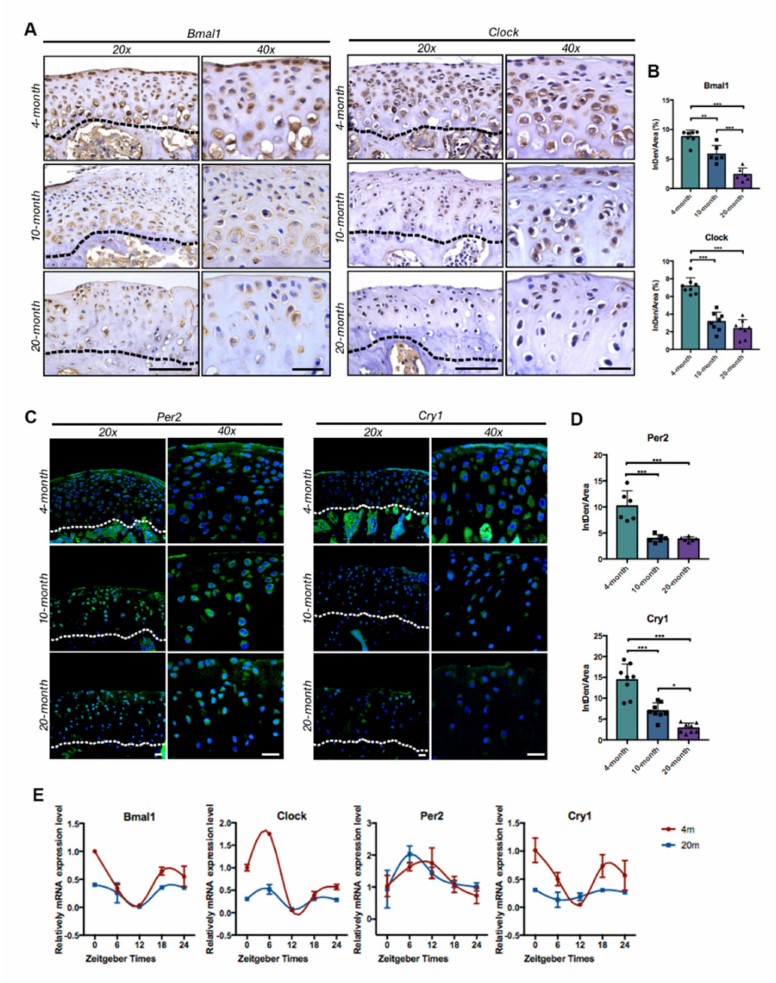
Figure 3. Decreased expression of core circadian clock genes and blunted molecular rhythms of aged TMJ cartilage. ( A ) Representative images of immunostaining for BMAL1 and CLOCK in TMJ condyles in different age groups. Scale bar: 75 µ m for 20 × and 25 µ m for 40 × . ( B ) Quantification of percentage of positive staining in data A ( n = 6–8) * p < 0.05, ** p < 0.01, *** p < 0.001. ( C ) Representative images of immunostaining (fluorescent) for Per2 and Cry1 in TMJ condyles in different age groups. Scale bar: 20 µ m. ( D ) Quantification of percentage of positive staining in data C ( n = 6–8) * p < 0.05, ** p < 0.01, *** p < 0.001. ( E ) qRT-PCR analyses of molecular rhythmic expression of circadian clock genes ( Bmal1 , Clock , Per2 , and Cry1 ) in 4-month-old and 20-month-old TMJ condylar cartilage. The black (or white) dotted lines indicated the osteochondral interface of TMJ